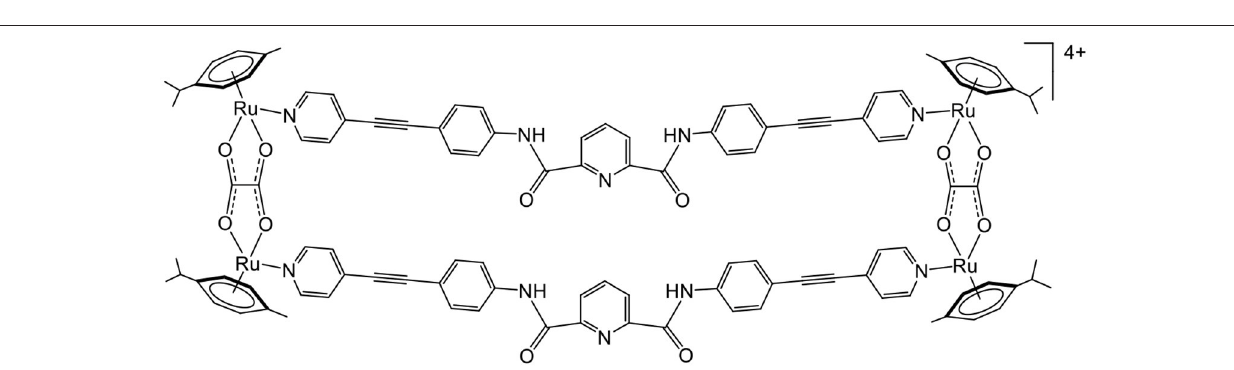
FIGURE 5 | Arene ruthenium metalla-rectangle interacting with EGF protein (Mishra et al.,